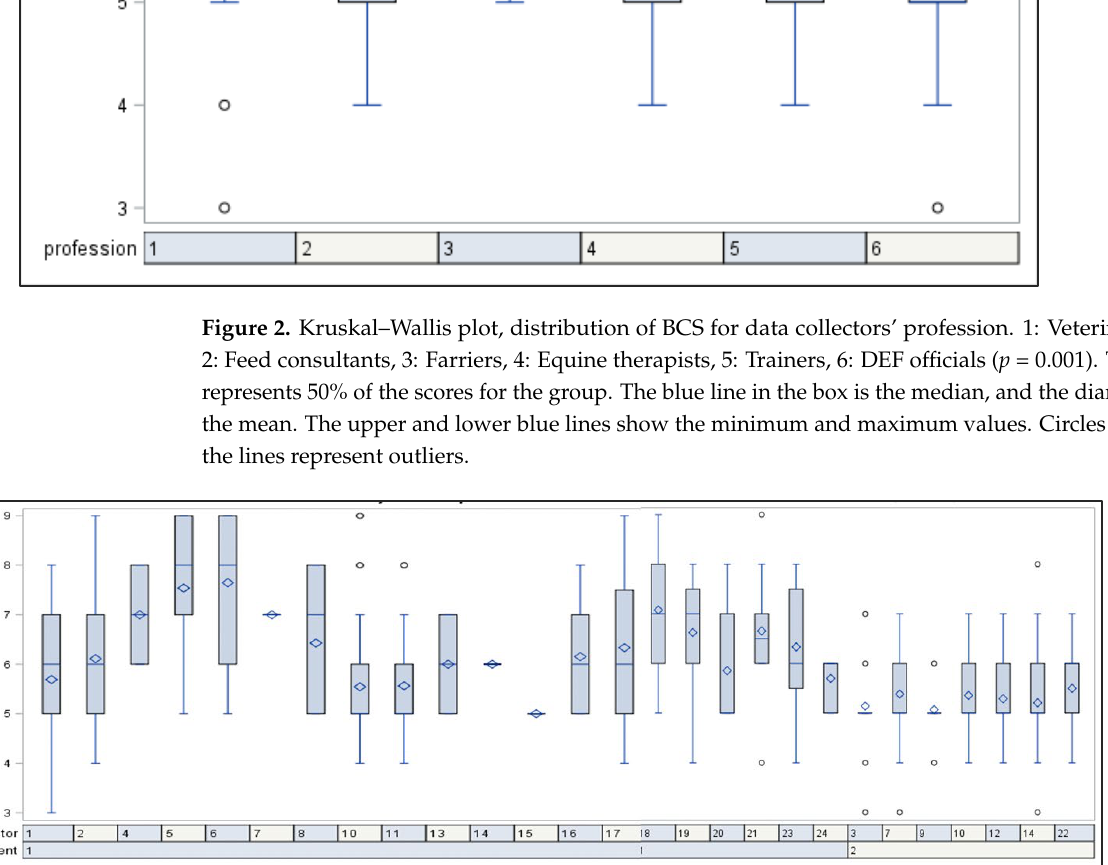
Figure 3. Distribution of the body condition score per collector. The distribution for consent type 2 is evenly distributed (DEF officials scoring horses at events). The box represents 50% of the scores for the group. The blue line in the box is the median, and the diamond is the mean. The upper and lower blue lines indicate the minimum and maximum values. Circles outside the lines represent outliers.